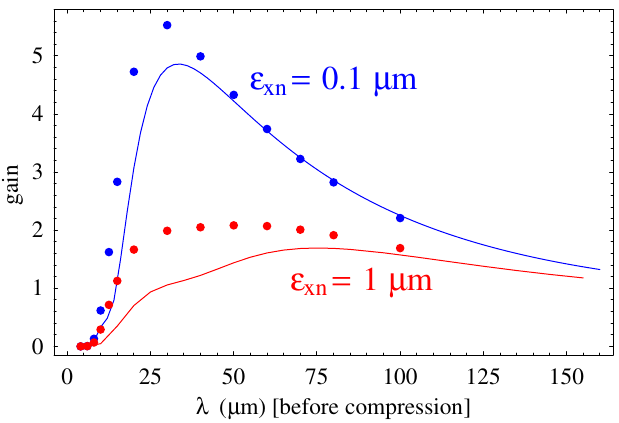
(cid:2) s (cid:4) and H (cid:2) s (cid:4) functions in FERMI first bunch 56